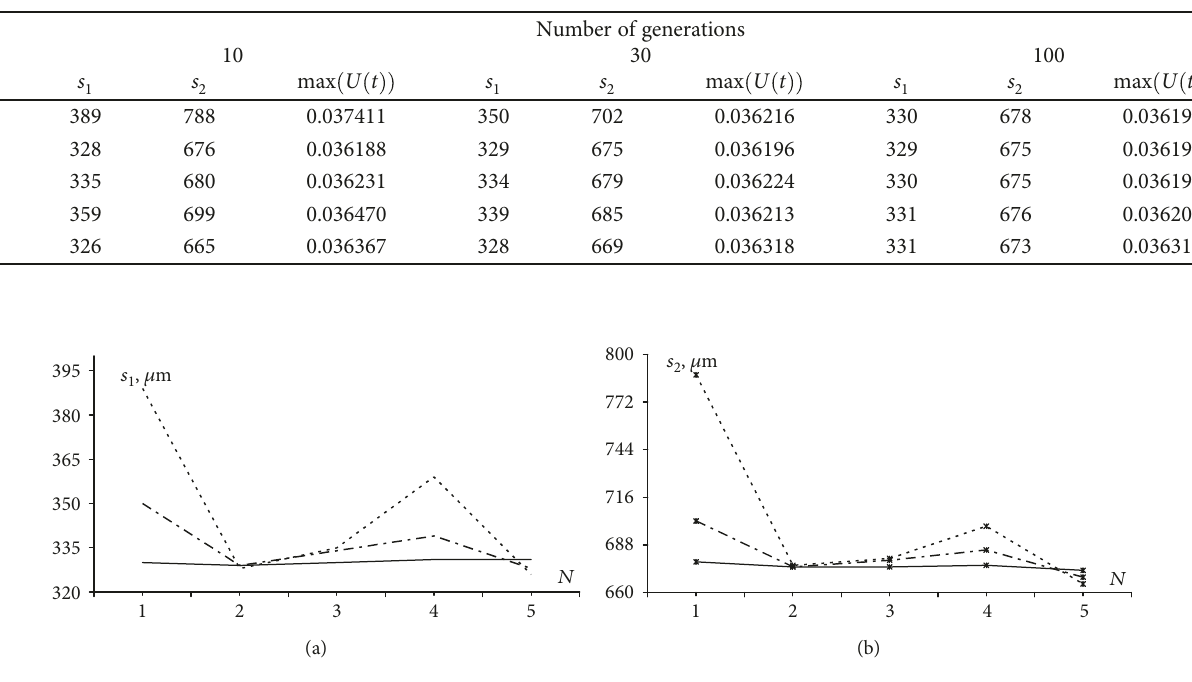
(a) and s (b) values for 10 individuals and 10 ( ··· ), 30 ( – · – ), and 100 ( — ) 1 2